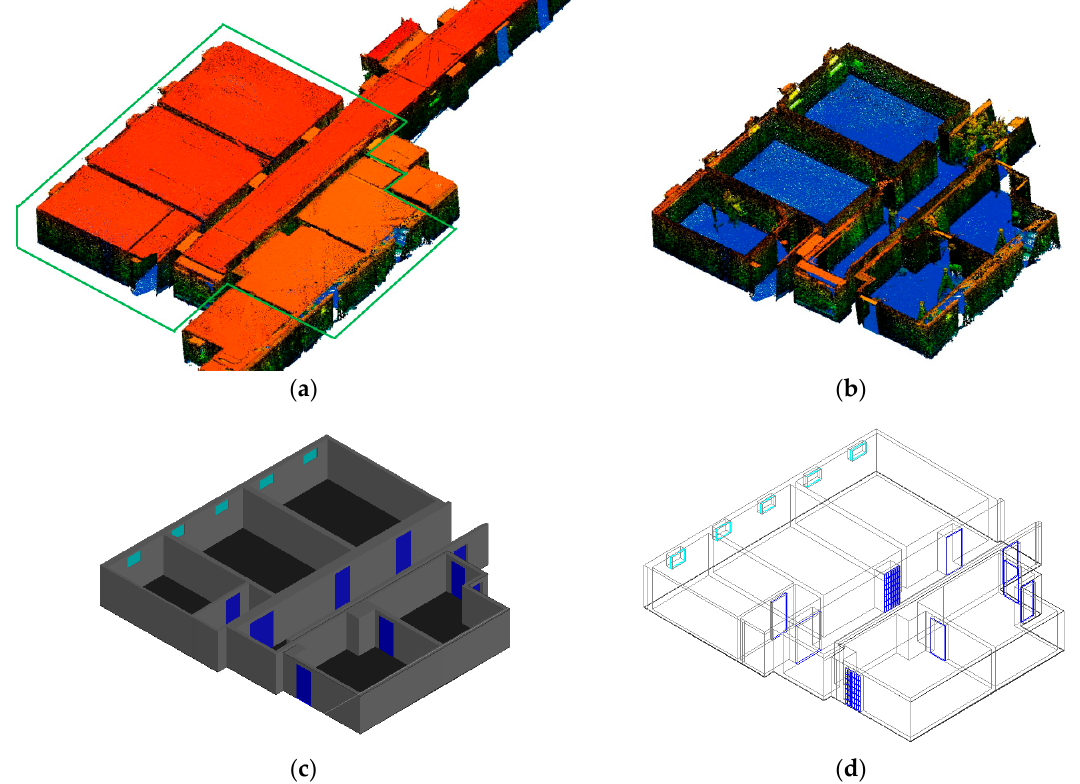
Figure 11. Experimental results: ( a ) the input point cloud and the analyzed area (green boundaries); ( b ) a detail of the analyzed area without the ceiling; ( c ) the reconstructed model without ceiling; and ( d ) a wireframe view of the model. Table 2. Parameters adopted during data